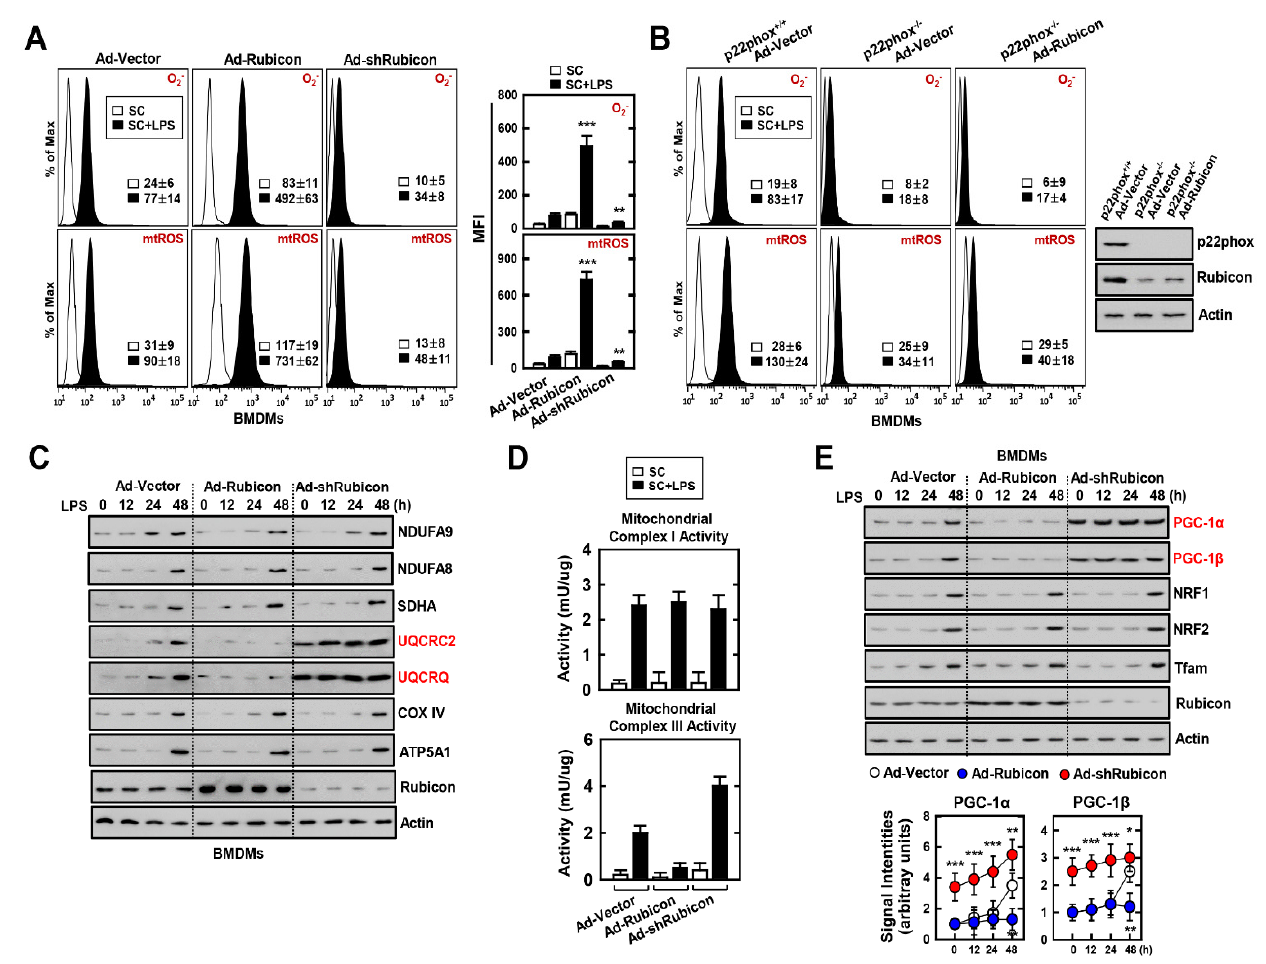
Figure 3. Effects of Rubicon–p22phox interaction in the mitochondrial activity and biogenesis. ( A , B ) BMDMs were transduced with Ad-Rubicon, Ad-shRubicon, or Ad-Vector (MOI = 10) for 2 days and stimulated with LPS (100 ng/mL) for 30 min. FACS analysis for superoxide (up) and mitoROS (down). Quantitative analysis of mean fluorescence intensities of ROS (box). p22phox and Rubicon expression by IB ( B , right). ( C ) BMDMs was stimulated with LPS (100 ng/mL) for indicated times and subjected to IB with α NDUFA9, α NDUFA8, α SDHA, α UQCRC2, α UQCRQ, α COX IV, α ATP5A1, α Rubicon, and α Actin. ( D ) Mitochondrial Complex I (up) and III (down) Activity. ( E ) BMDMs was stimulated with LPS (100 ng/mL) for the indicated times and subjected to IB with α PGC-1 α , α PGC-1 β , α NRF1, α NRF2, α Tfam, α Rubicon, and α Actin (up) and signal intensity of PGC-1 α and PGC-1 β were measured in indicated times (down). Data shown are the means ± SD of three experiments ( A , B , D ). Data shown are representative of five independent experiments with similar results ( C , E ). Statistical significance was determined by Student’s t -test with Bonferroni adjustment (* p < 0.05; ** p < 0.01; *** p < 0.001) compared with